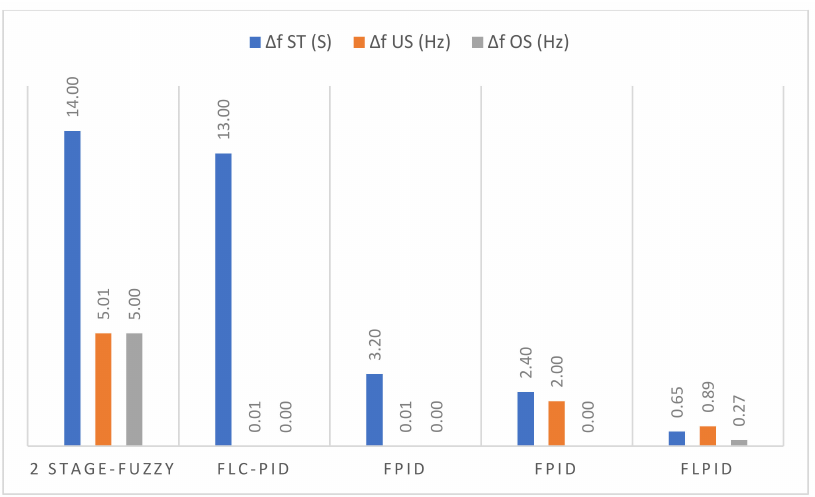
Figure 12. Frequency Deviation for Isolated